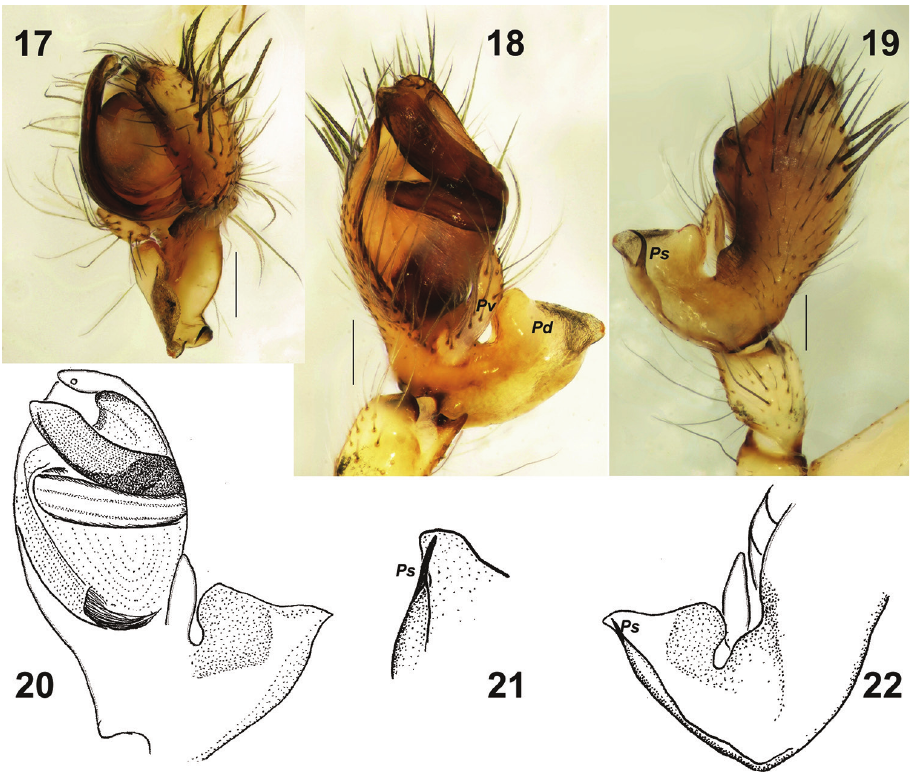
Figures 17–22. Male palp of Metellina orientalis ( 17–19 ) from Azerbaijan and M. kirgisica ( 20–22 ). 17 from above 18, 20 ventral 19, 22 dorsal 21 tip of paracymbium with spur. Pd dorso-retrolateral arm Ps spur like process Pv finger-like ventral arm. Scale bars 0.2 mm ( 17, 18, 19 )